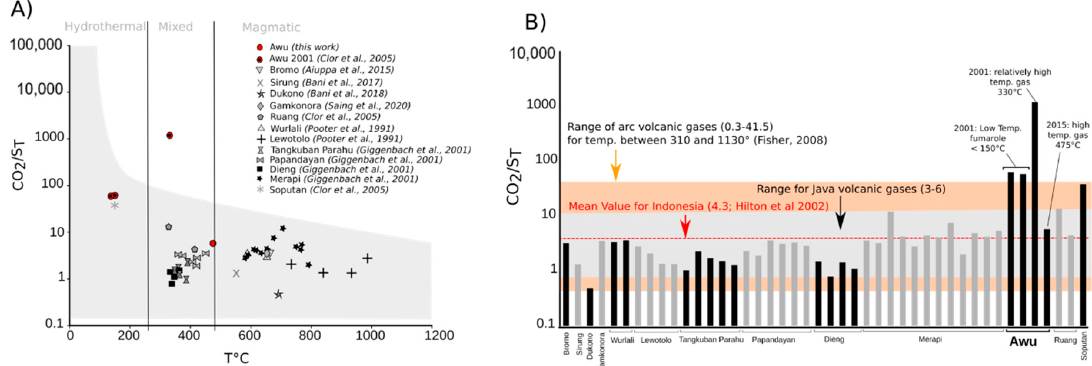
Figure 7. ( A ) Variation of the CO 2 / S T ratios as a function of temperature for the Indonesian volcanoes. The diagram discriminates the magmatic gas signature (Merapi, Bromo, Dukono, Sirung, Wurlali, and Lewotolo) from the hydrothermal (low-temperature fumarole at Awu and Soputan) and mixed gases composition (Papandayan, Dieng, Tangkuban Parahu, Ruang, and the high-temperature gas from Awu). ( B ) The CO 2 / S T ratios highlight the strong CO 2 signature of Awu above the means value of Indonesian volcanoes and above the arc volcanic gases. Awu CO 2 signature is also higher than the Java arc, considered as the CO 2 -enriched arc